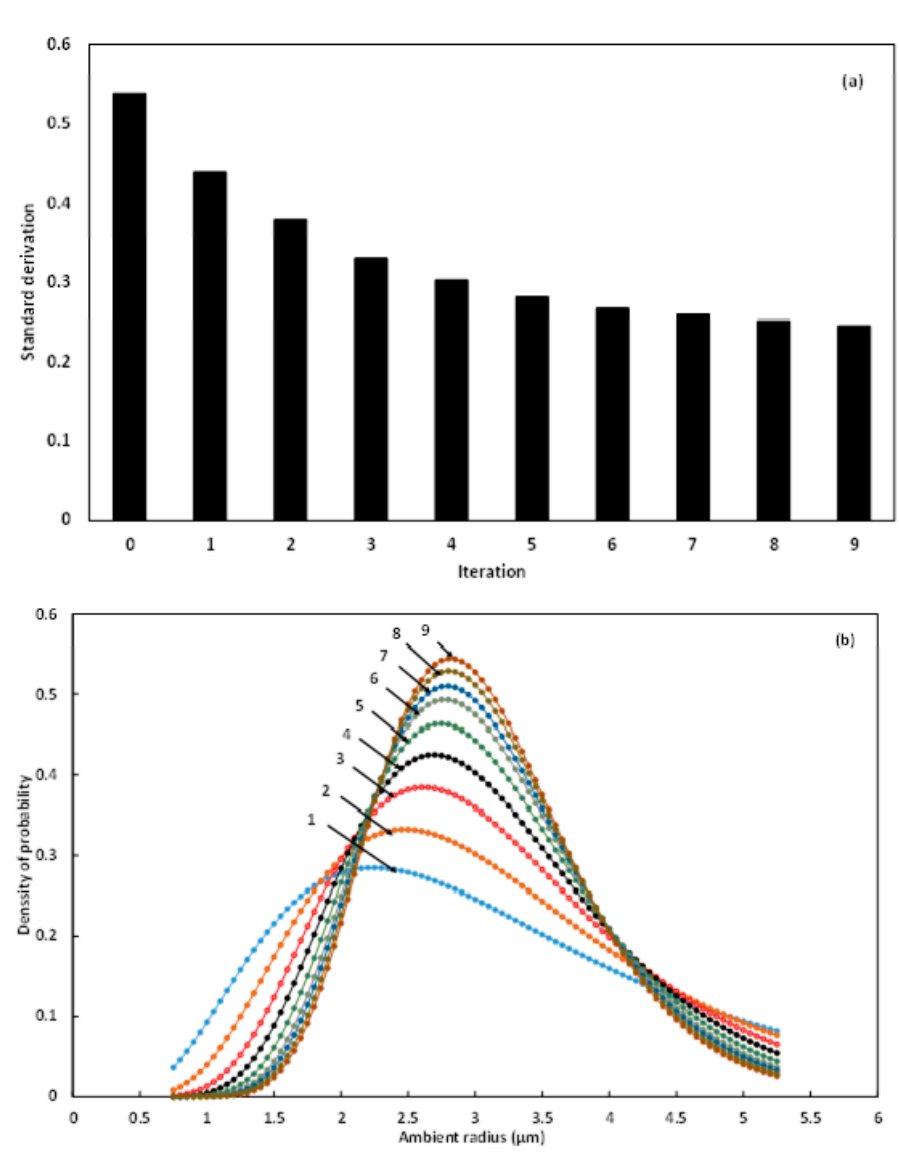
Figure 5. Standard deviation ( a ) and probability density ( b ) of equilibrium radii distribution at successive iteration until